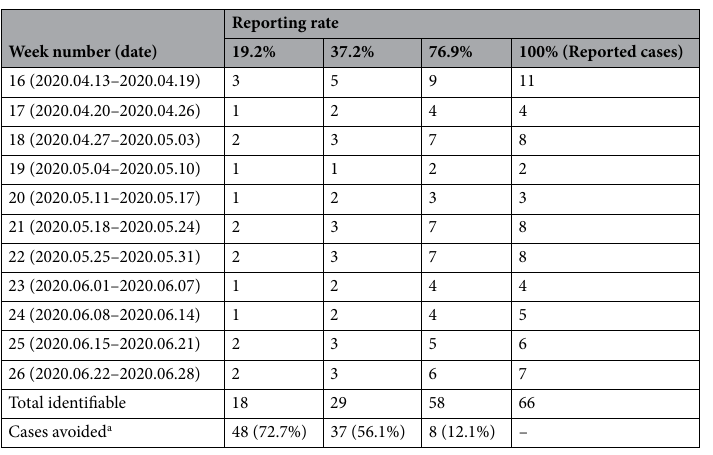
Table 2. Estimated identifiable and avoided imported cases at different reporting rate assumptions. a Cases avoided = Total number of reported imported cases − Total number of expected imported cases for each reporting rate